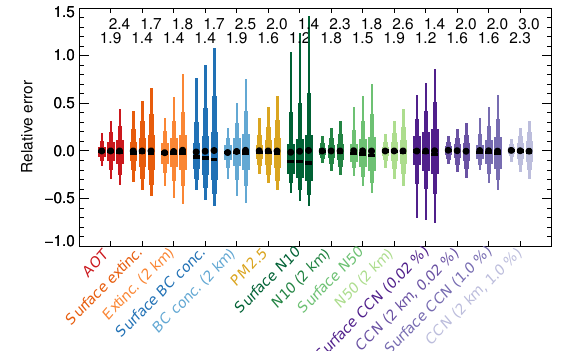
Figure 15. Relative spatial sampling error (monthly data) as a func- tion of distance of the observation to the grid point. The numbers near the top horizontal axis show the increase of (cid:49)q 82 at 70 and 100km relative to 0km. Results from WRF-Chem MADE over W. Europe. Further explanation in Sect. 3.2.